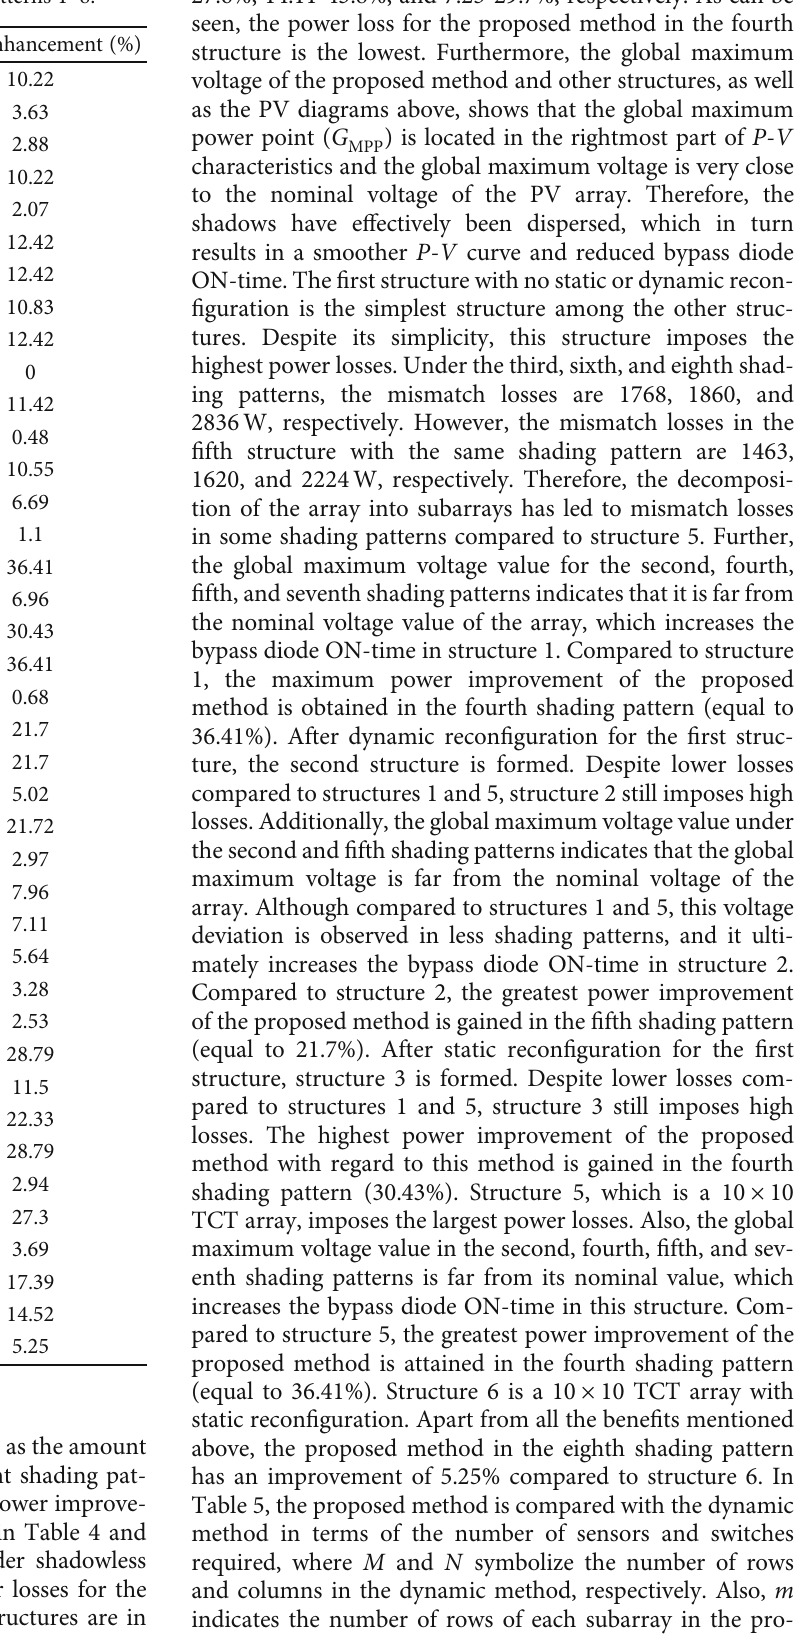
Table 4: Power enhancement for shading patterns 1 –